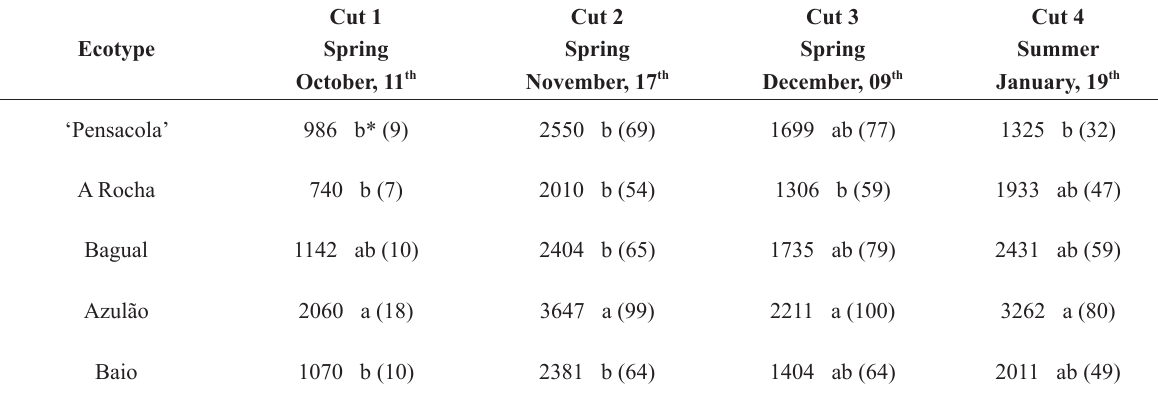
Total dry matter production (TDM) in kg/ha in each cut in the second year of evaluations of ecotypes of Paspalum spp. and cv. ‘Pensacola’, EEA-UFRGS, Eldorado do